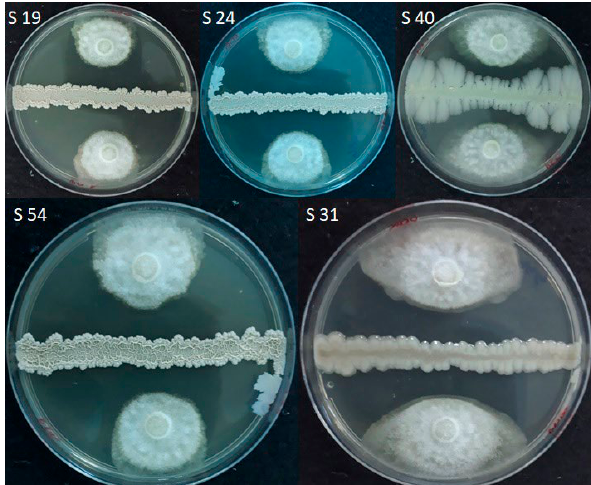
Figure 1. Dual culture showing antagonistic activities of the endo- phytic bacteria (strains S19, S24, S31, S40 and S54) toward Phytoph- thora citrophthora